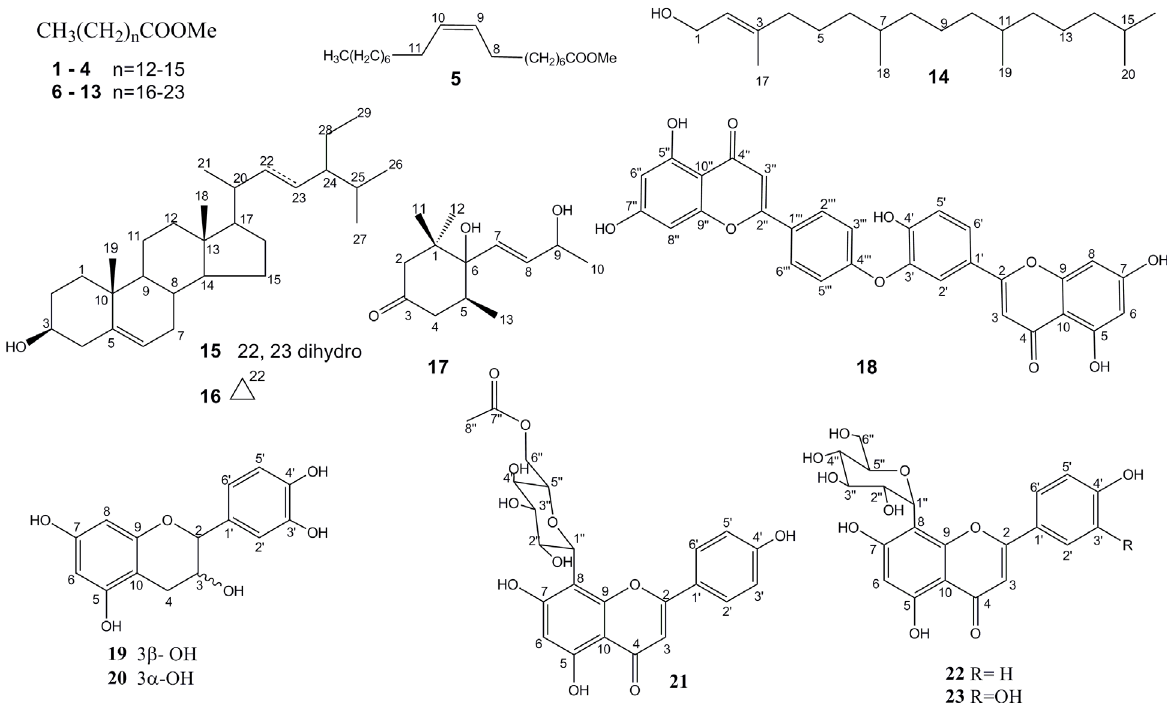
Figure 1. Compounds isolated from Cespedesia